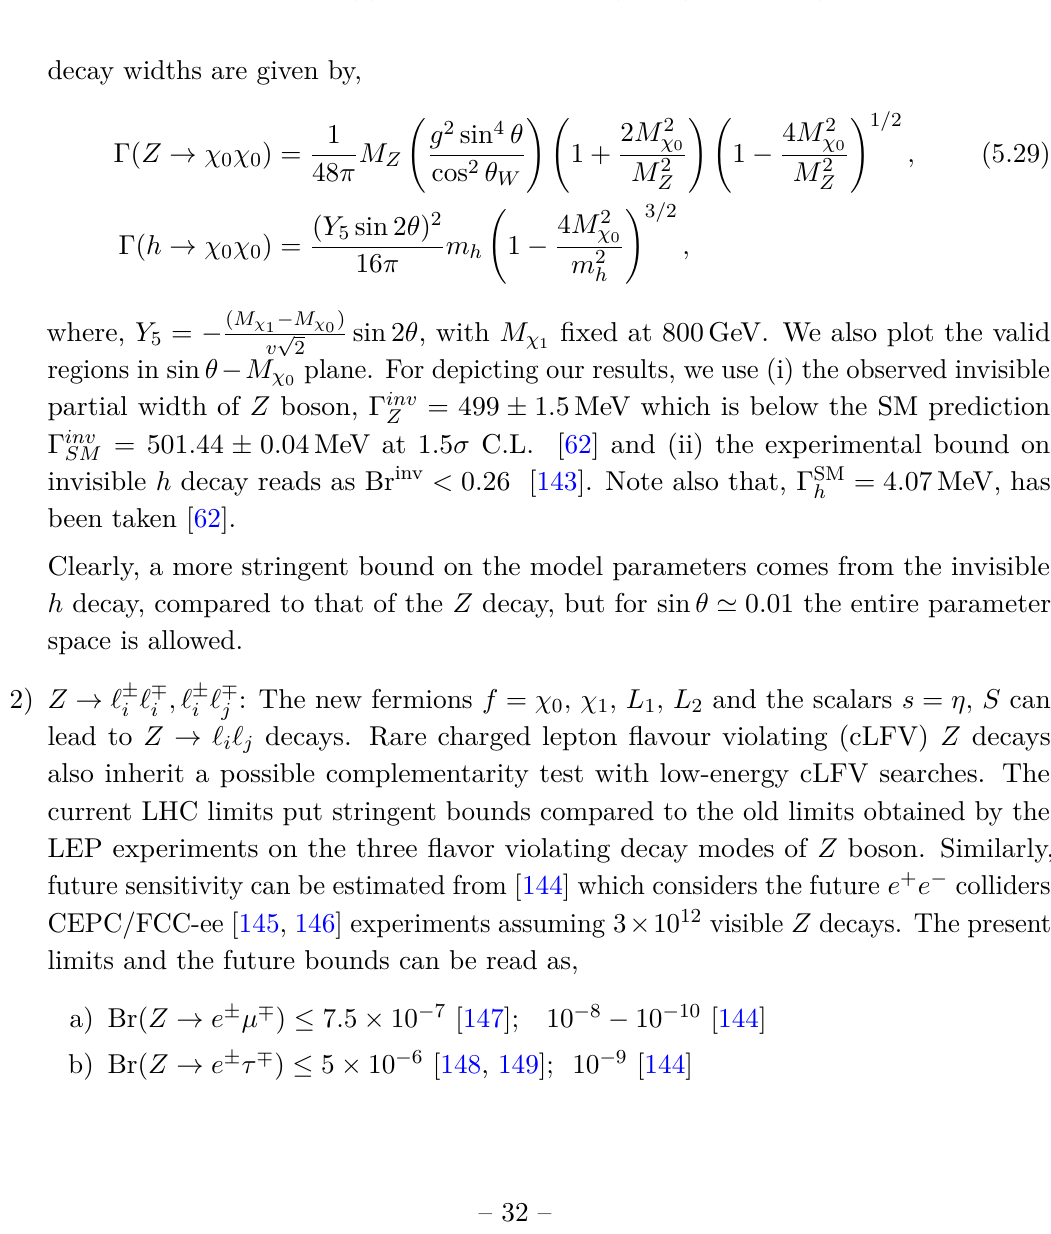
2 ’ 62 GeV) decay h /